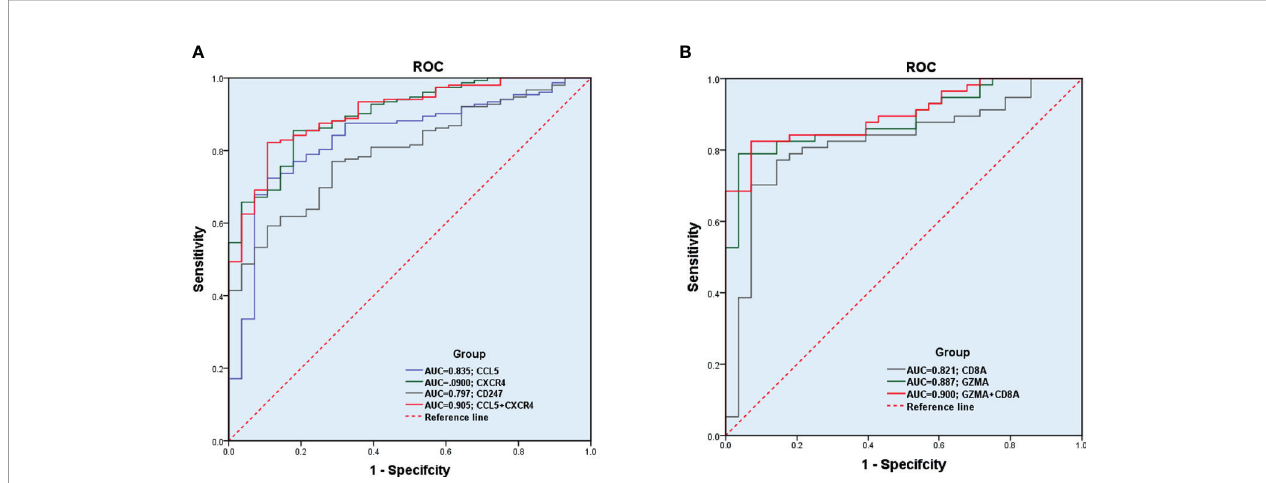
FIGURE 8 | Diagnostic effectiveness of the biomarkers for RA. (A, B) The GSE89408 dataset was used to validate the diagnostic effectiveness of the biomarkers for RA by ROC